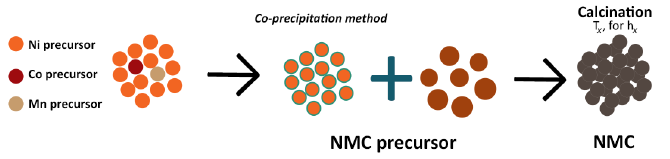
Figure 9. NMC cathodes synthesis: NMC secondary particles (precursor) obtained by co-precipitation of transition metal precursors followed by calcination for h x hours at fixed temperature T x . Adapted from